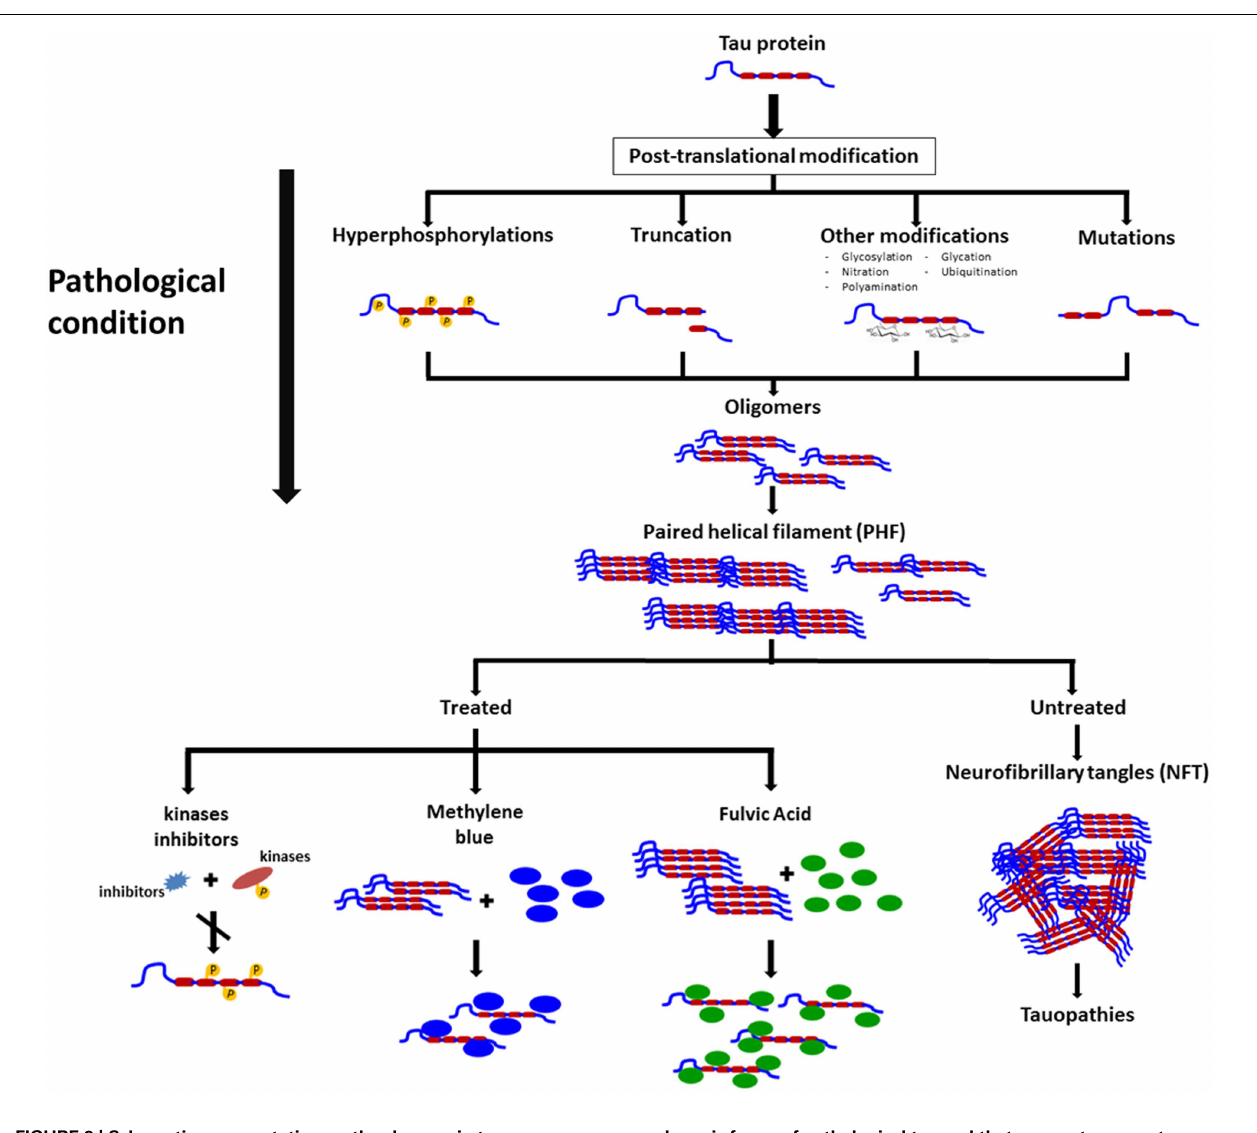
FIGURE 2 | Schematic representation on the changes in tau leading to pathological conditions, formation of neurofibrillary tangles, and some molecules that exert their actions on